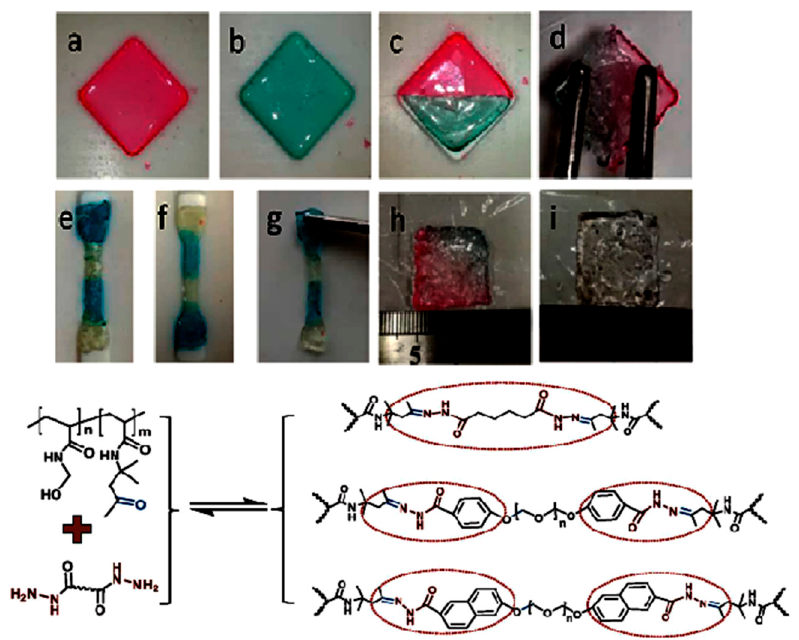
Figure 2. Self-healing properties of hydrogel prepared from P(AM 71 - stat -DAA 14 ) and PEO 23 DH cross-linking ( a – d ), the reshaping process ( e – g ), and the swell property in pH 7.4 buffer ( h , i ) ( upper ). Cross-linking led to a self-healing hydrogel that responds to temperature and has a gel-sol–gel transition. It is made up of dynamic covalent bonds ( lower ).